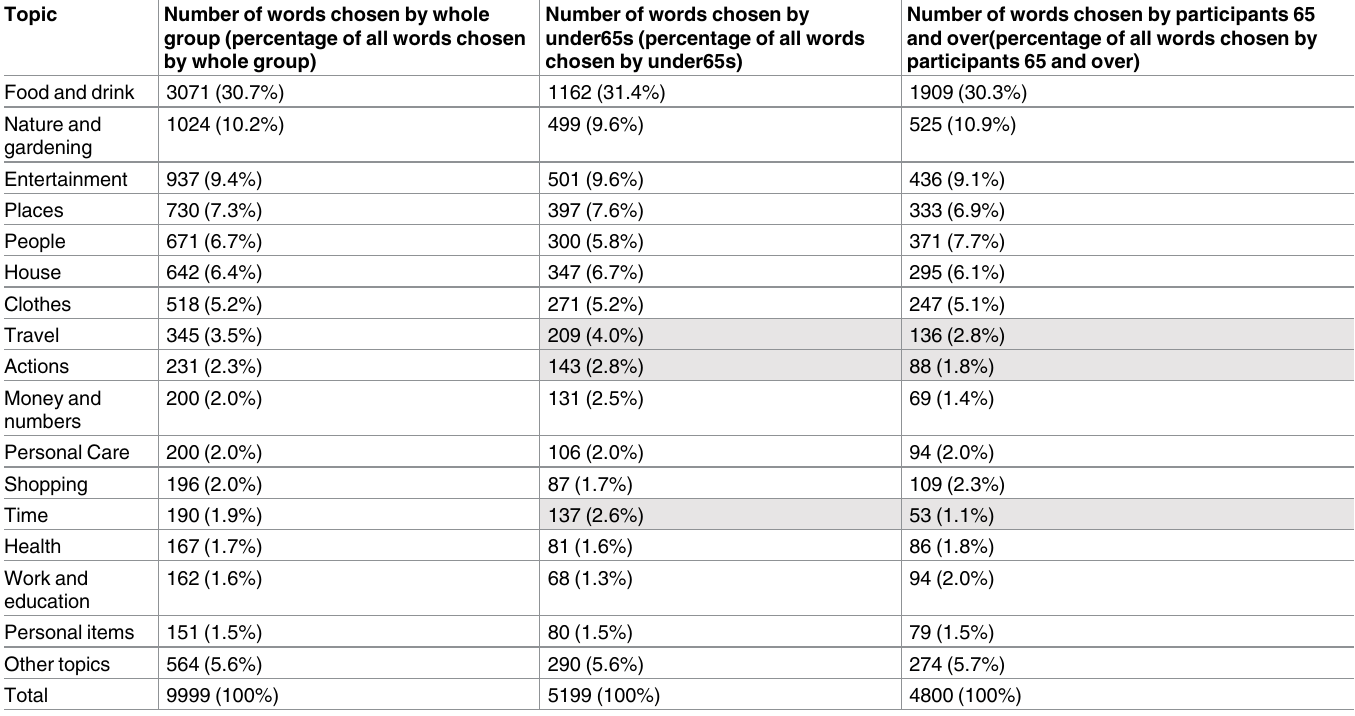
Table 4. The number of words chosen from each topic by age.